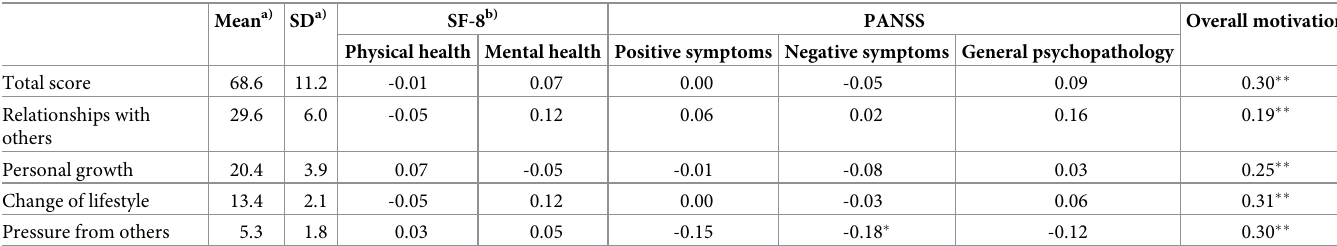
Table 3. Pearson’s correlations of the new scale scores to SF-8, PANSS and the score on overall motivation to work (N = 136).